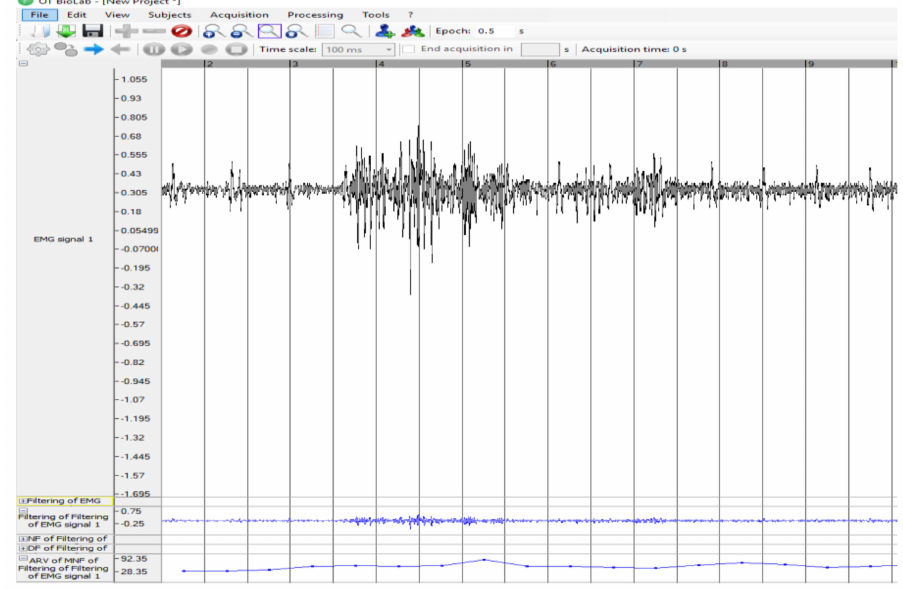
Figure 4. The interface of the software used to process sEMG signal with an example of the EMG signal 1 (black line), and derivation of the ARV (second blue line from the bottom), and the filtered signal (blue bottom line). On the abscissa the time in